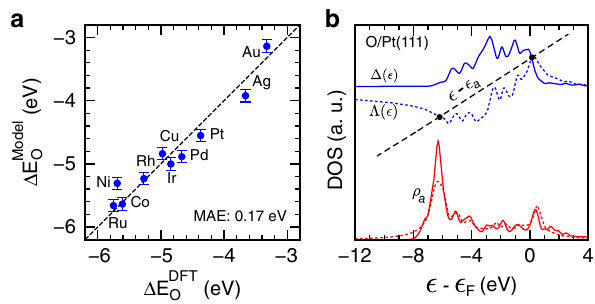
Fig. 3 Model-predicted adsorption properties. a DFT-calculated *O adsorption energies (atomic O as the reference) at transition-metal surfaces vs. model prediction using the posterior distribution of model ! ; σ ! ). Error bars represent the standard deviation of model parameters ( θ prediction with 1000 random draws from converged trajectories. b Projected density of states ρ a onto the O 2 p orbital from DFT calculations (solid) and model prediction (dashed) using the posterior means of model parameters, taking Pt(111) as an example. The graphical solution to the Newns – Anderson model is also shown, in which Δ ( ϵ ) and Λ ( ϵ ) represent the chemisorption function, and ϵ a is the adsorbate resonance energy level.